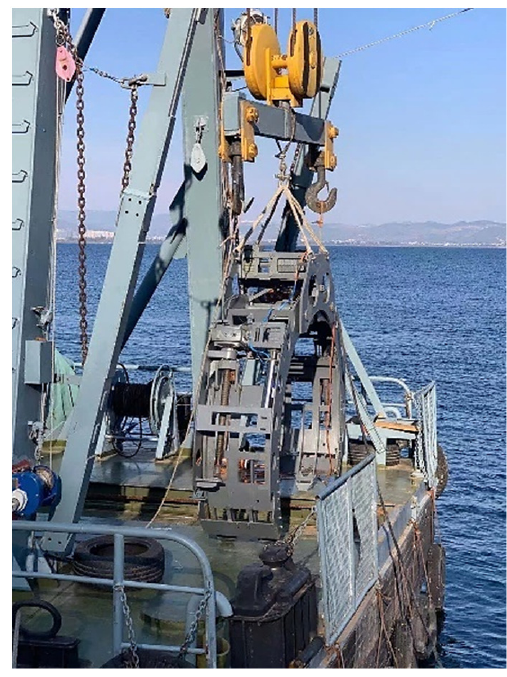
Figure 14. Launch of the manipulator.